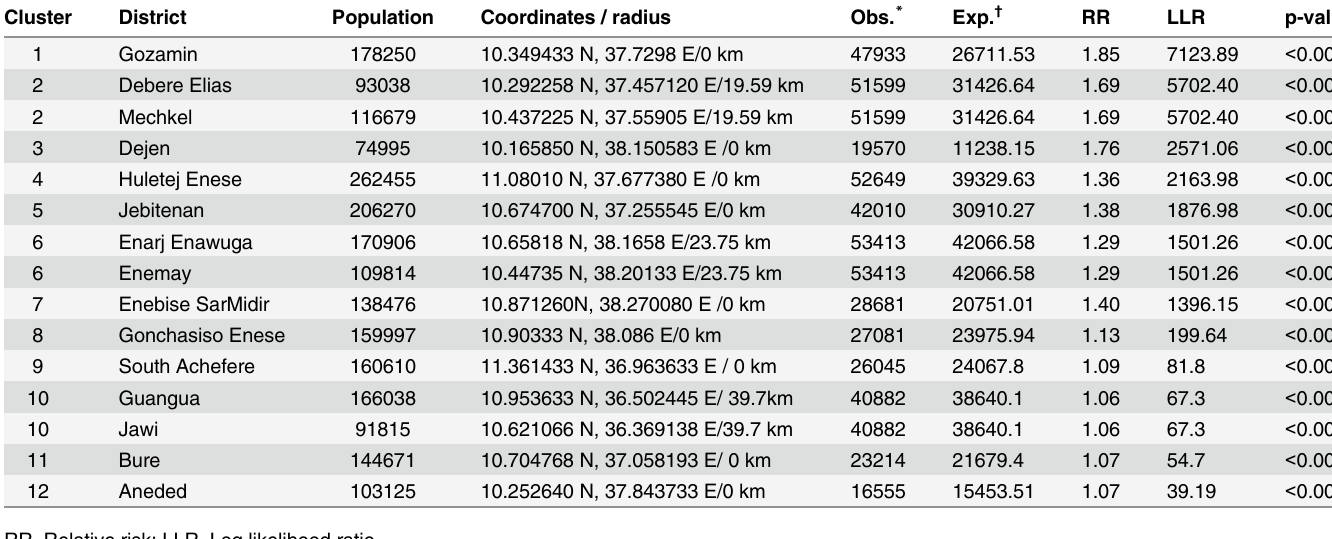
Table 2. Spatial clusters of childhood diarrhea in northwest Ethiopia between 1 July 2007 and 30 June